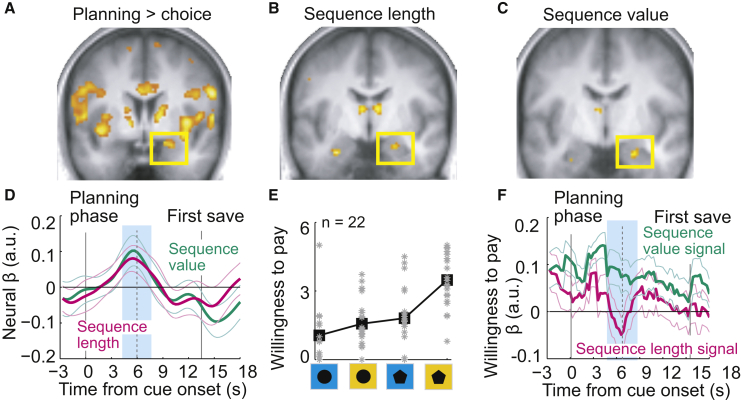
Amygdala Planning Activity Reflects Economic Saving Strategies(A) Stronger amygdala activity in the planning phase compared to the choice phase (cluster p values corrected for family-wise error across the whole brain; map thresholded at p < 0.005, uncorrected for display purposes, extent threshold ≥ 10 voxels).(B) Amygdala activity in the planning phase predicted the length of the forthcoming choice sequence (p < 0.05, small volume correction).(C) Amygdala activity in the planning phase reflected sequence value, i.e., the subjective value of the forthcoming choice sequence (p < 0.05, small volume correction). Sequence value was derived from observed choice frequencies for different saving sequences.(D) Region-of-interest analysis. The graph shows a regression of amygdala activity on sequence length and sequence value. Both factors explained significant variance (p < 0.05, random-effects multiple linear regression; sequence length t(23) = 2.43; sequence value t(23) = 2.45). Neural βs indicate mean regression weights from fitting a multiple linear regression model containing both sequence length and value regressors to neural activity in each subject. Thin colored lines indicate SEM across subjects. “Planning phase” indicates onset of planning phase (at 0 s); “first save” indicates onset of first save trial in sequence. The blue shaded box indicates the analysis period at the expected delay of the hemodynamic response.(E) Behavior in a separate economic task. Subjects (n = 22) performed an economic auction-like (Becker-DeGroot-Marschak [BDM]) task in which they placed willingness-to-pay bids on the same rewards and choice sequences as in the saving experiment. The mean bids per condition are shown for each subject (gray data points) and means across subjects (black).(F) Amygdala planning activity, measured during the saving task, predicted willingness-to-pay bids in the auction-like task. Only the sequence value signal (green βs, based on sequence value-correlated amygdala activity during the saving task) predicted willingness-to-pay bids (p < 0.05, random-effects multiple linear regression; sequence value signal t(21) = 2.45).See also Figures S4 and S5.